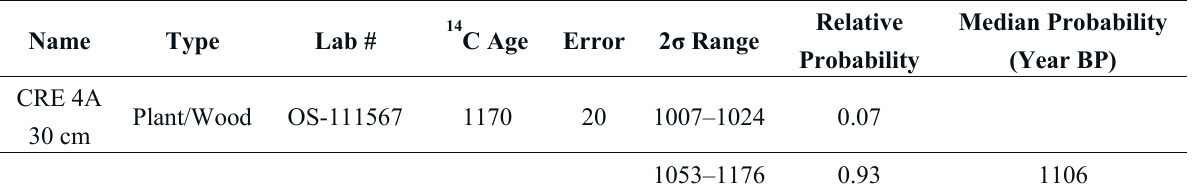
Table 2. Radiocarbon and calibrated dates of sediment sample from Core